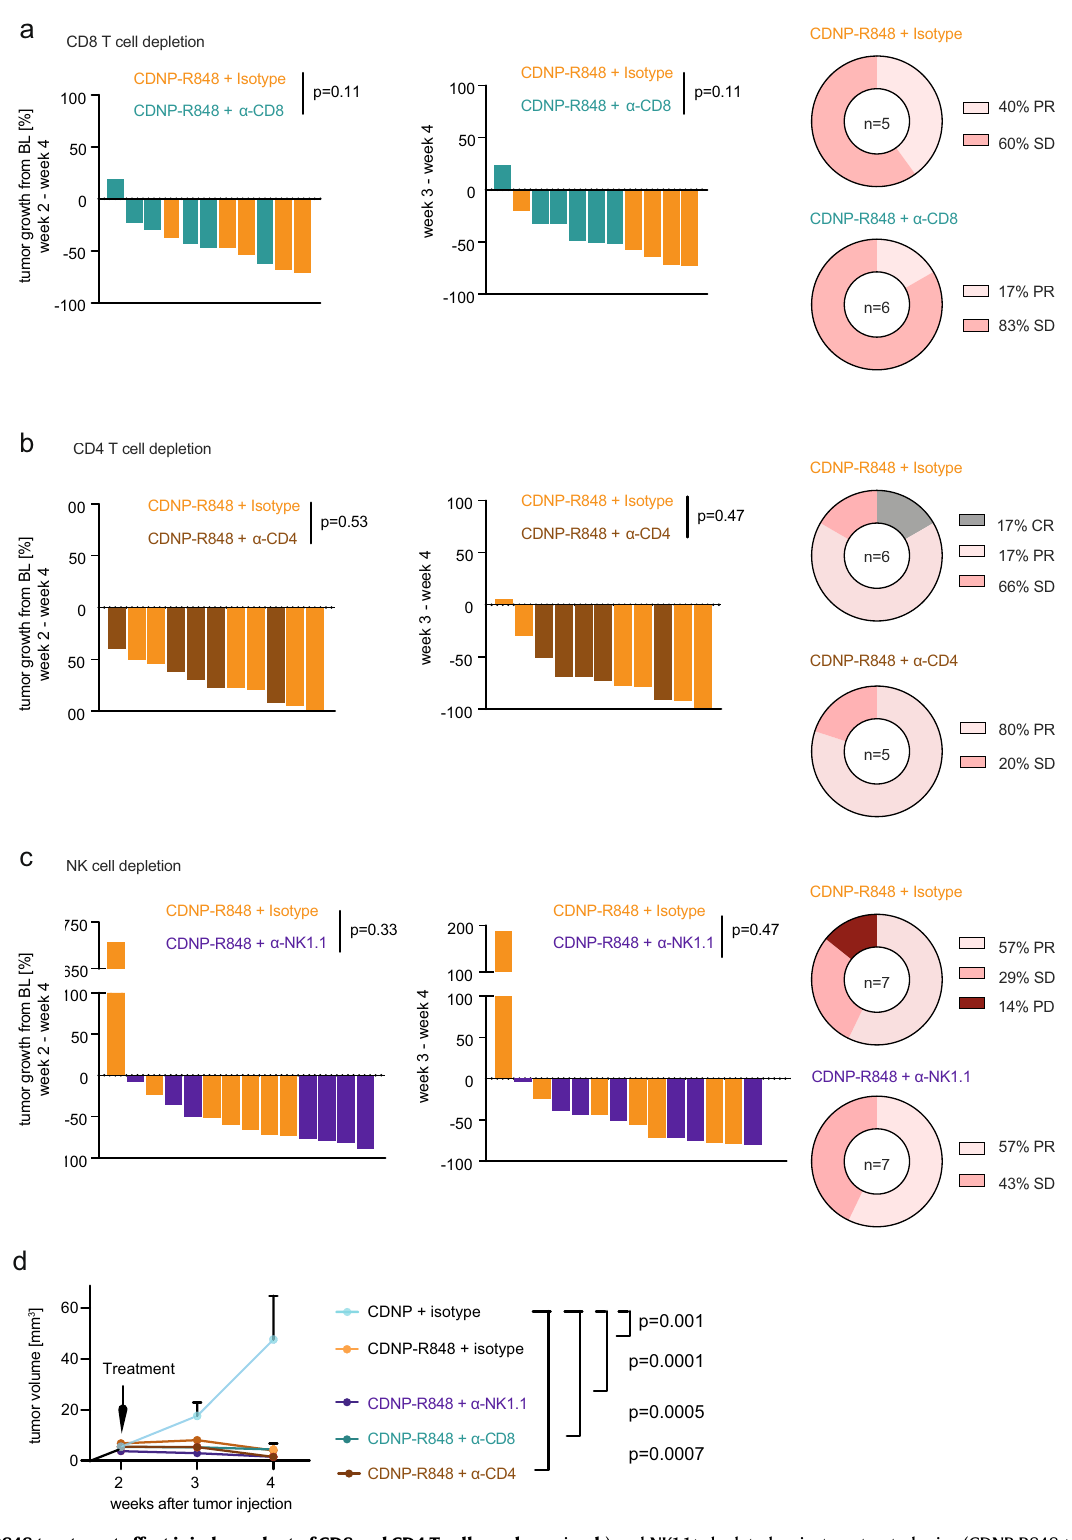
Fig.4|CDNP-R848treatmenteffectisindependentofCD8andCD4Tcells,and NKcells.a – c Waterfallplotoftumorvolumes(left)andresponseassessment(right) for immune cell depletion experiments. CD8 + T cells, CD4 + T cells or NK1.1 +